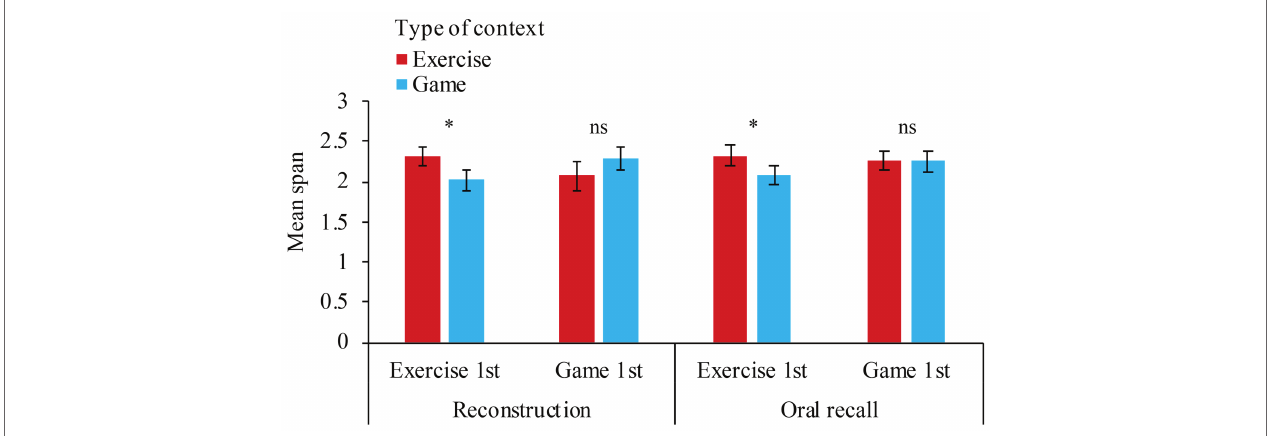
FIGURE 1 | Mean span as a function of the type of contexts (exercise vs. game), the order of presentation of the context conditions (exercise in 1st vs. game in 1st), and the type of tests (reconstruction vs. oral recall). Vertical bars represent SEs. Ns for non-significant difference on t -tests comparing the type of contexts in each pair of conditions and * for significant difference at p <